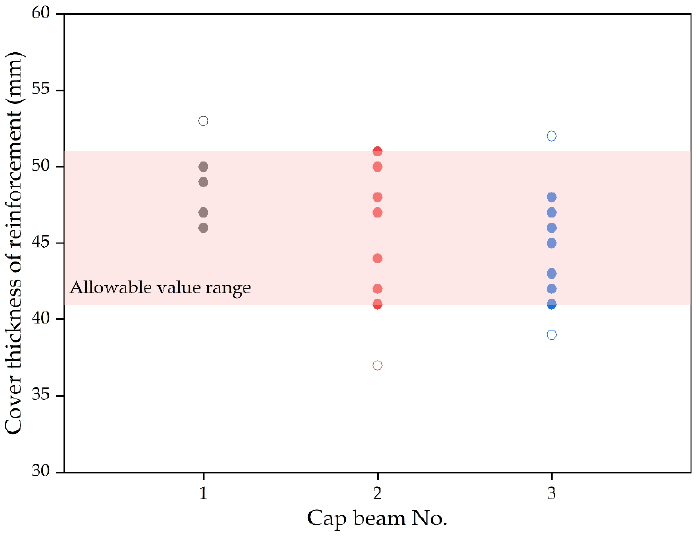
Figure 9. The cover thickness values of reinforcement for prefabricated cap beam specimens.